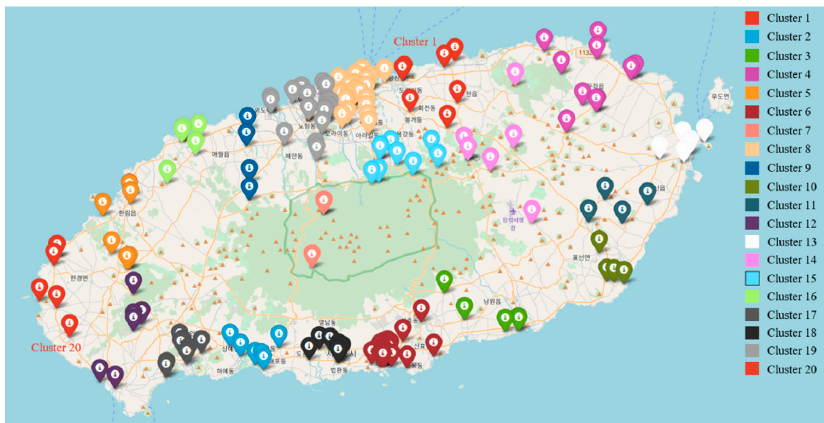
Figure 6. Electric vehicle charging stations on Jeju island clustered by the location of stations. Each color represents each cluster.